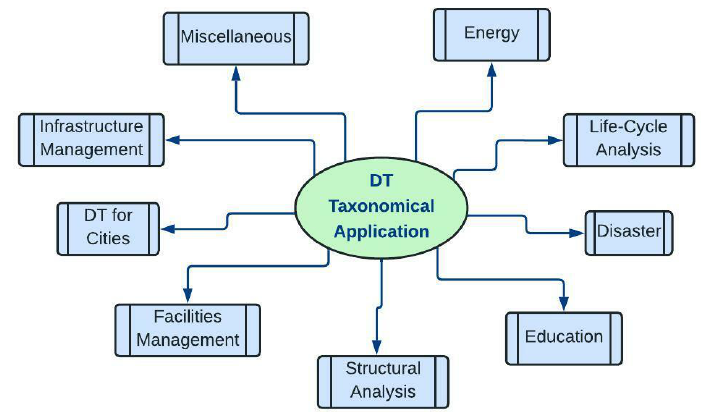
Figure 3. Taxonomy of DT Applications.